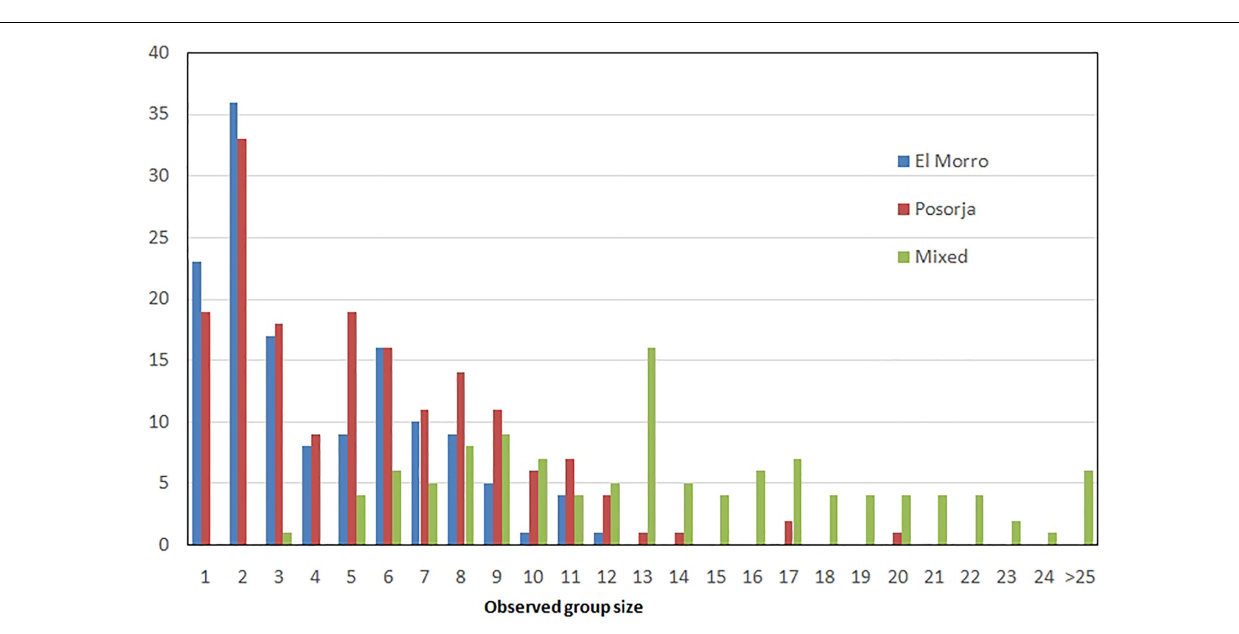
time dependant {Phi(g) p(t)} ( Supplementary Table 1 ). In